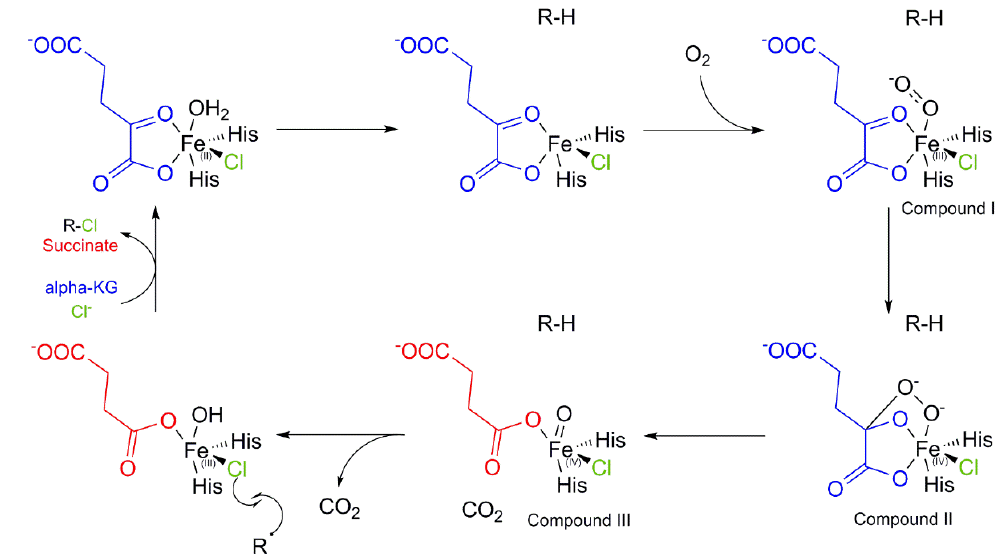
Figure 22. Catalytic cycle of NHFe halogenase inspired by Butler et al. [75].